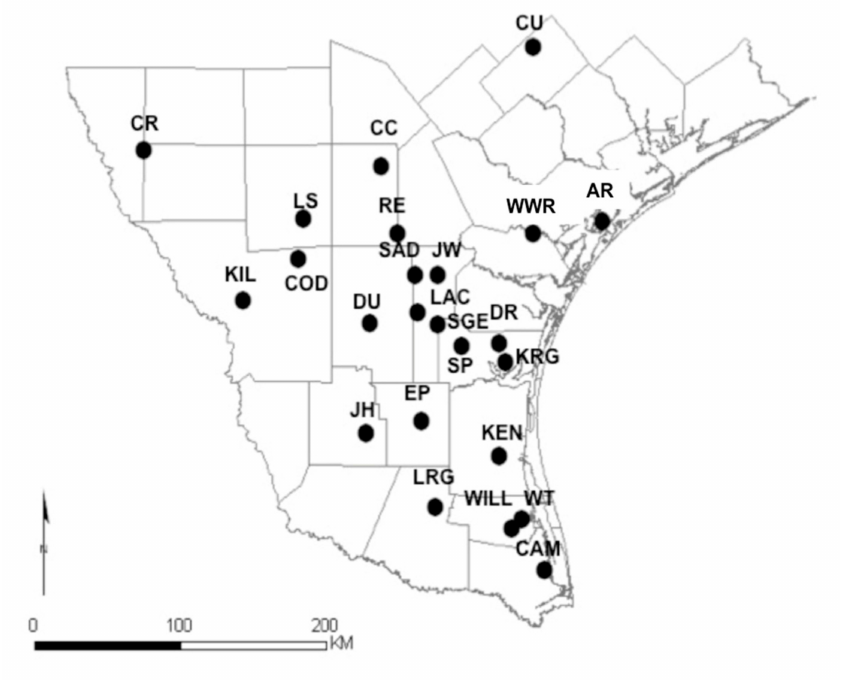
Figure 1. Study sites and sampling locations of tissue samples distributed along southern Texas. Study sites are labeled in the figure. Aransas National Wildlife Refuge (AR), Cameron County (CAM), Choke Canyon State Park (CC), Kubala’s Ranch (COD), Comanche Ranch (CR), Cuero County (CU), Don Ricardo pasture, Laureles Division of King Ranch (DR), Duval County (DU), El Pintor Ranch (EP), Jim Hogg County (JH), Jim Wells County (JW), Kenedy Ranch (KEN), Killam Ranch (KIL), Gallito pasture, Laureles Division of King Ranch (KRG), the Texas A&M Extension Service La Copita Research Area (LAC), Lower Rio Grande Valley National Wildlife Refuge (LRG), La Salle County (LS), Rancho Escondido (RE), San Diego County (SAD), South Pasture-Texas A&M-Kingsville (SP), Willacy County (WILL), Wilbarger Tract, Lower Rio Grande Valley National Wildlife Refuge (WT), Rob and Bessie Welder Wildlife Refuge (WWR), and Santa Gertrudis division of King Ranch